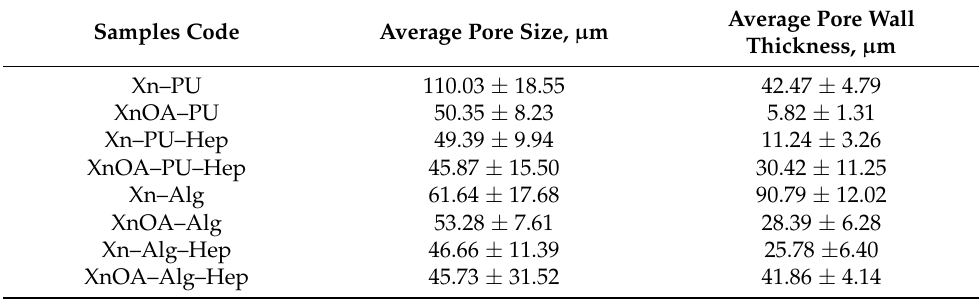
Table 1. Average pore sizes and pore wall thicknesses for all sponges were determined from SEM micrographs with ImageJ1.41o.